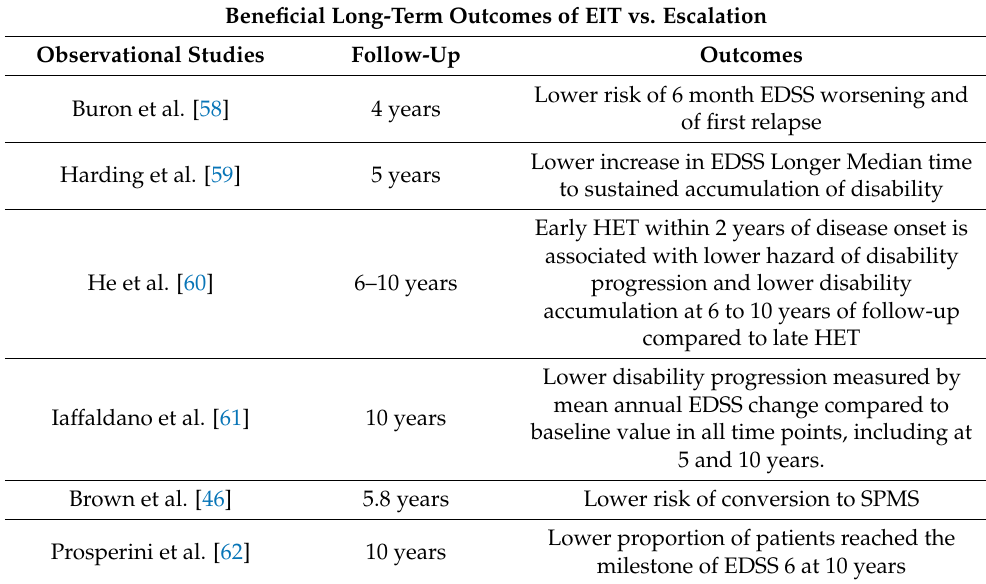
Table 2. Long-term outcomes of Early Intensive Treatments: Observational Studies. Beneficial Long-Term Outcomes of EIT vs. Escalation Observational Studies